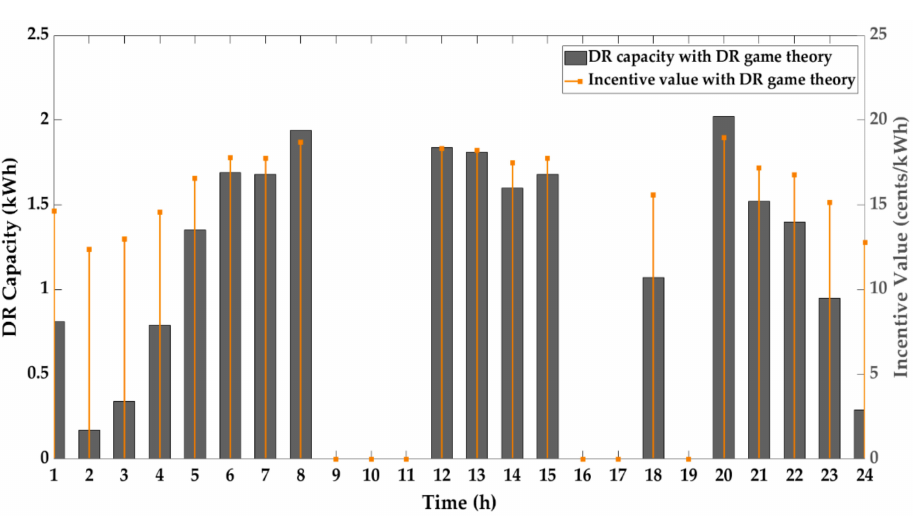
Figure 8. Proposed DR strategy